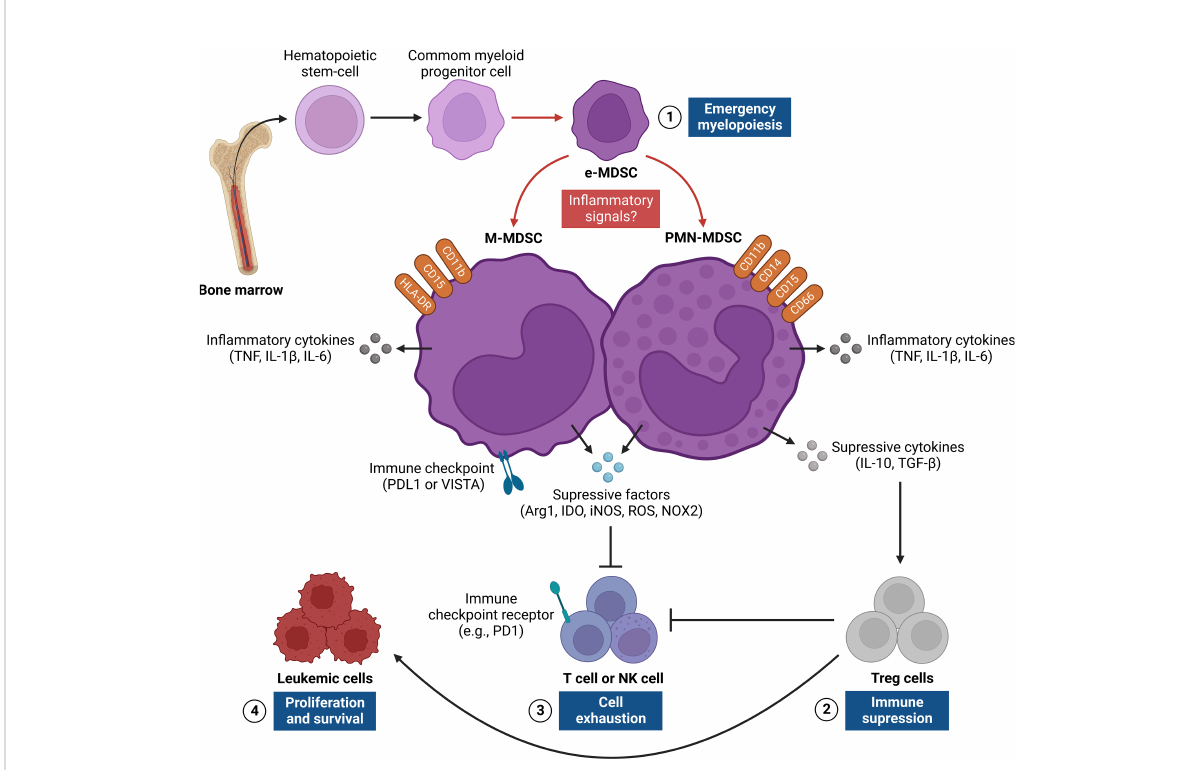
FIGURE 3 Regulation of MDSC responses in the leukemic microenvironment. The fi gure shows the origin and pro-tumor activities of myeloid-derived suppressor cells (MDSCs), which provide critical signals for leukemic progression. This network of interactions between MDSCs, LCs, and other immune cells [e.g., T cells, NK cells, and Treg cells] results in four main events: [1] emergence of MDSCs in bone marrow from common myeloid progenitor cells that differentiate into PMN-MDSC and M-MDSC after persistent in fl ammatory signals, thus characterizing a process known as “ emergency myelopoiesis ” ; [2] activation and recruitment of Treg cells through the release of regulatory cytokines (e.g., IL-10, TGF- b ), which contribute to immunosuppression of the leukemic microenvironment;[3] exhaustion of T and NK cells from different in fl ammatory (e.g., IL-6, TNF and IL-1 b ) and/or anti-in fl ammatory (e.g., IL-10, TGF- b , Arg1, IDO and iNOS) mediators and surface molecules (PDL1 or VISTA) expressed by MDSCs, which regulate antitumor responses;[4] LC proliferation and survival, which are a consequence of suppression of T cell and NK cell effector responses and activation of Treg cells in the leukemic microenvironment. Arg1, Arginase 1; IDO, Indoleamine; iNOS, nitric oxide synthase; M-MDSC, monocytic-MDSC; NK, Natural killer; PDL1, Programmed death-ligand 1; PMN-MDSC, polymorphic mononuclear- MDSC; TGF- b , Transforming growth factor beta; TNF, Necrosis factor tumoral; Treg, Regulatory T cells; VISTA, V-domain Ig suppressor of T cell